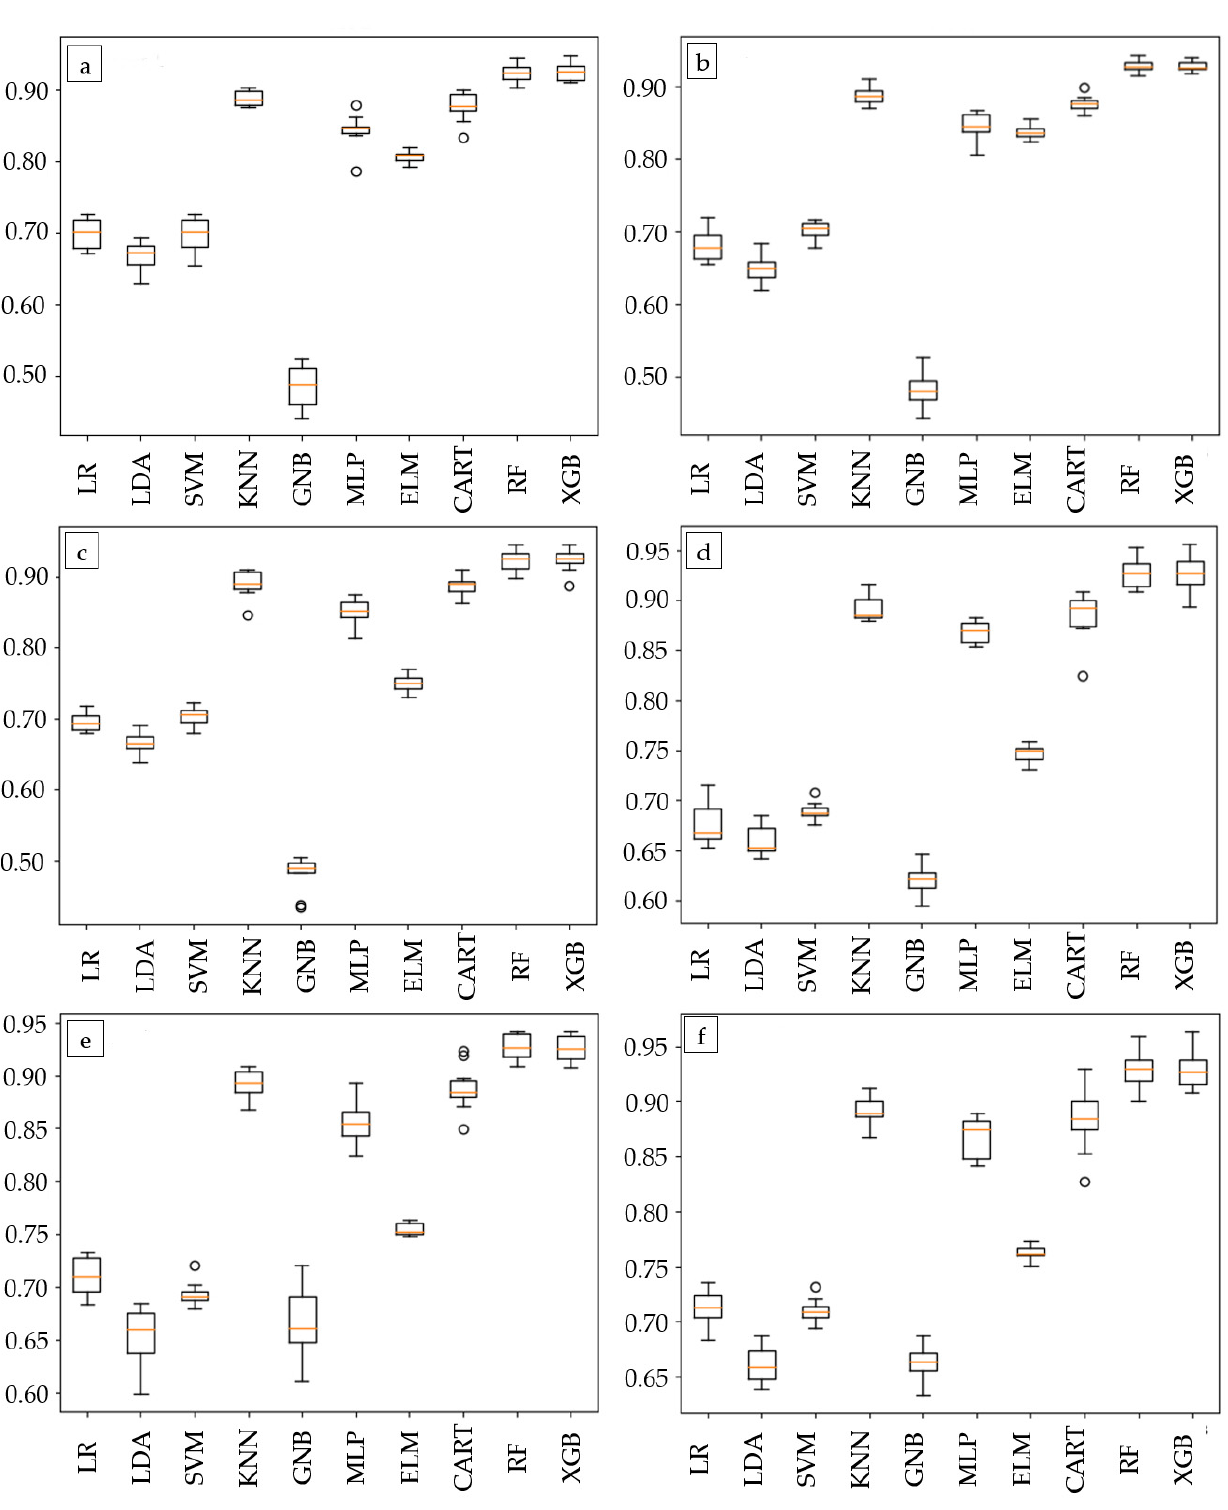
Figure 10. Boxplots of the simulation results: ( a ) Dataset 1, ( b ) Dataset 2, ( c ) Dataset 3, ( d ) Dataset 4, ( e ) Dataset 5, and ( f ) Dataset 6.